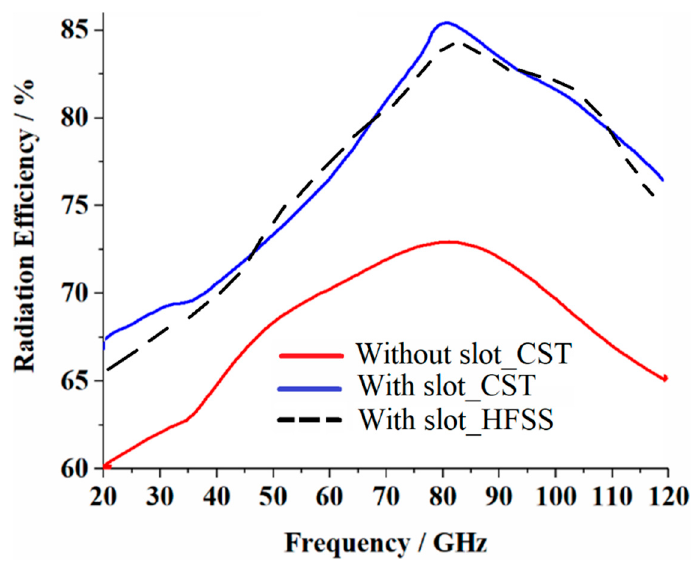
Figure 4. Gain response for both cases “with no” slots and “with” slots using two different commercially available 3D full wave electromagnetics simulation tools (CST Microwave Studio ® and HFSS™).